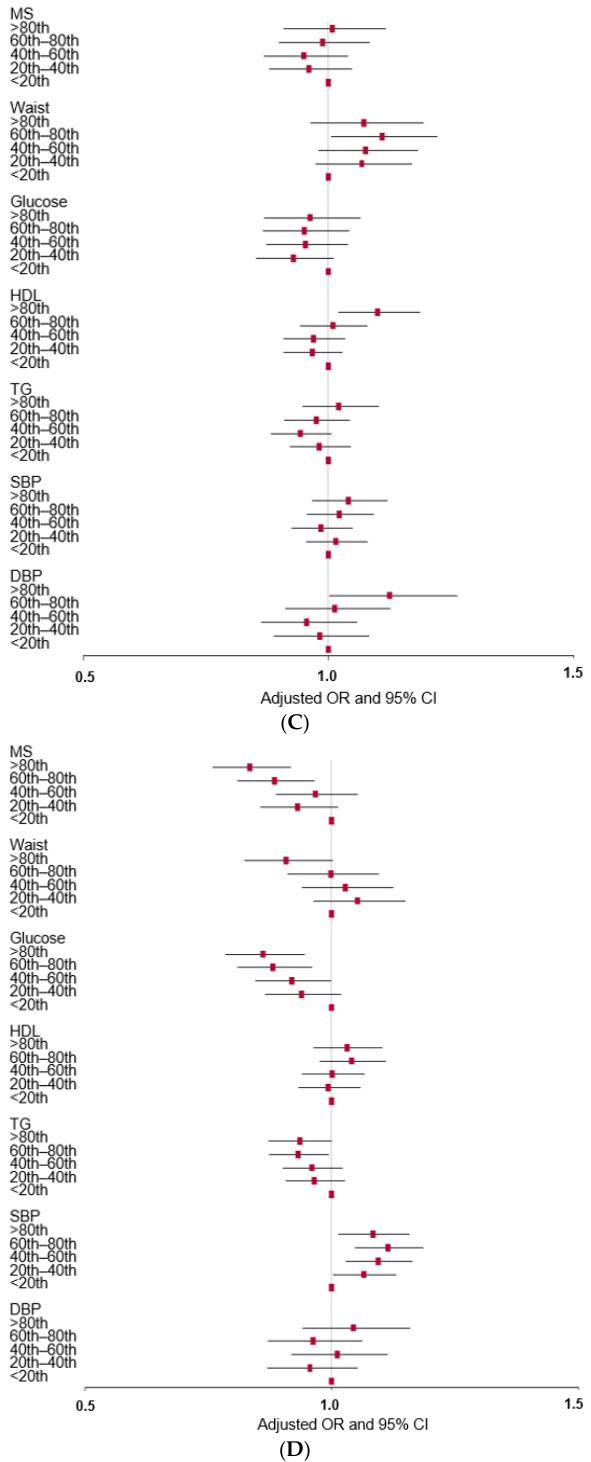
Figure 2. Association of plant-based diet (PBD) intake with metabolic syndrome (MetS) risk and its traits according to observational estimates in an urban hospital-based cohort. ( A ) Association of the quantiles of PBD intake with metabolic syndrome and its components; ( B ) association of the quantiles of vitamin C intake with metabolic syndrome and its components; ( C ) association of the quantiles of dietary fiber with metabolic syndrome and its components; ( D ) association of the quantiles of flavonoid intake with metabolic syndrome and its components. OR, odds ratio; CI, confidence intervals. The reference was the Low-PBD intake (<67th